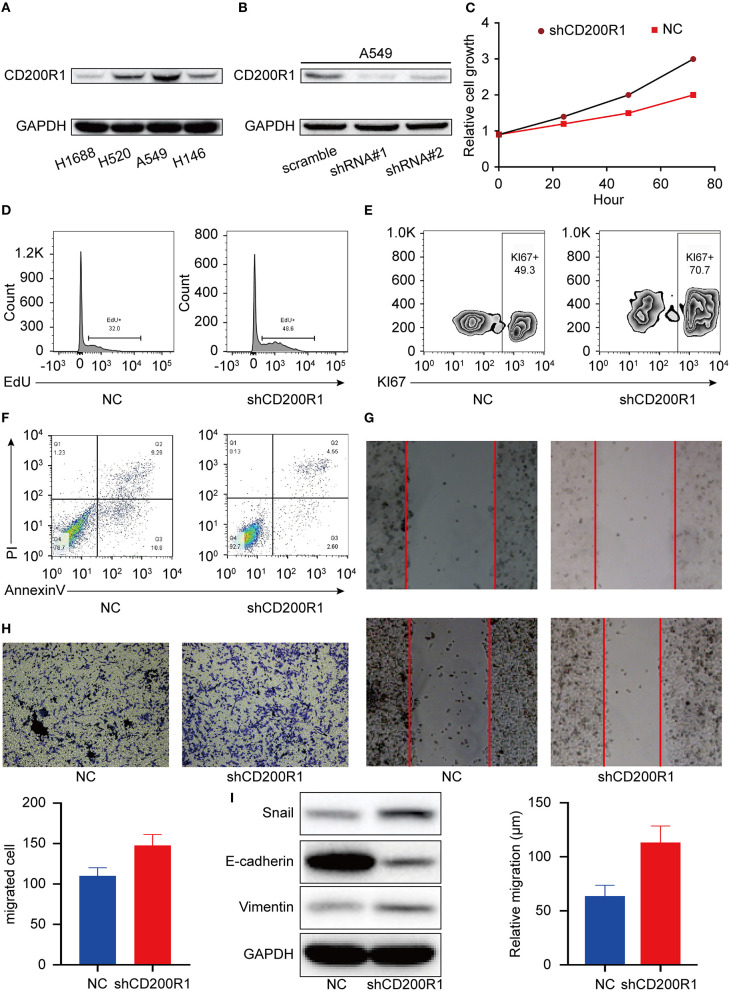
Biological behavior of CD200R1 in lung adenocarcinoma. (A) Baseline expression of CD200R1 in four kinds of cancer cells; (B) Two shRNA targeting CD200R1 was transfected into A549, effect of knock down was confirmed by western blot; (C) Cancer cell growth rate was increased after CD200R1 was knocked down; (D) S phase distribution was increased after CD200R1 was down-regulated. (E) Percentage of Ki67 positive was used to confirm the effect of CD200R1 on cell proliferation. (F) Apoptosis rate was studied by ANNEXINV stain; (G,H) The effect of CD200R1 on cell migration was studied by transwell and wound healing assay; (I) The expression of Snail and Vimentin was increased and that of E-cadherin was reduced, indicted EMT was occur after CD200R1 was knocked down.